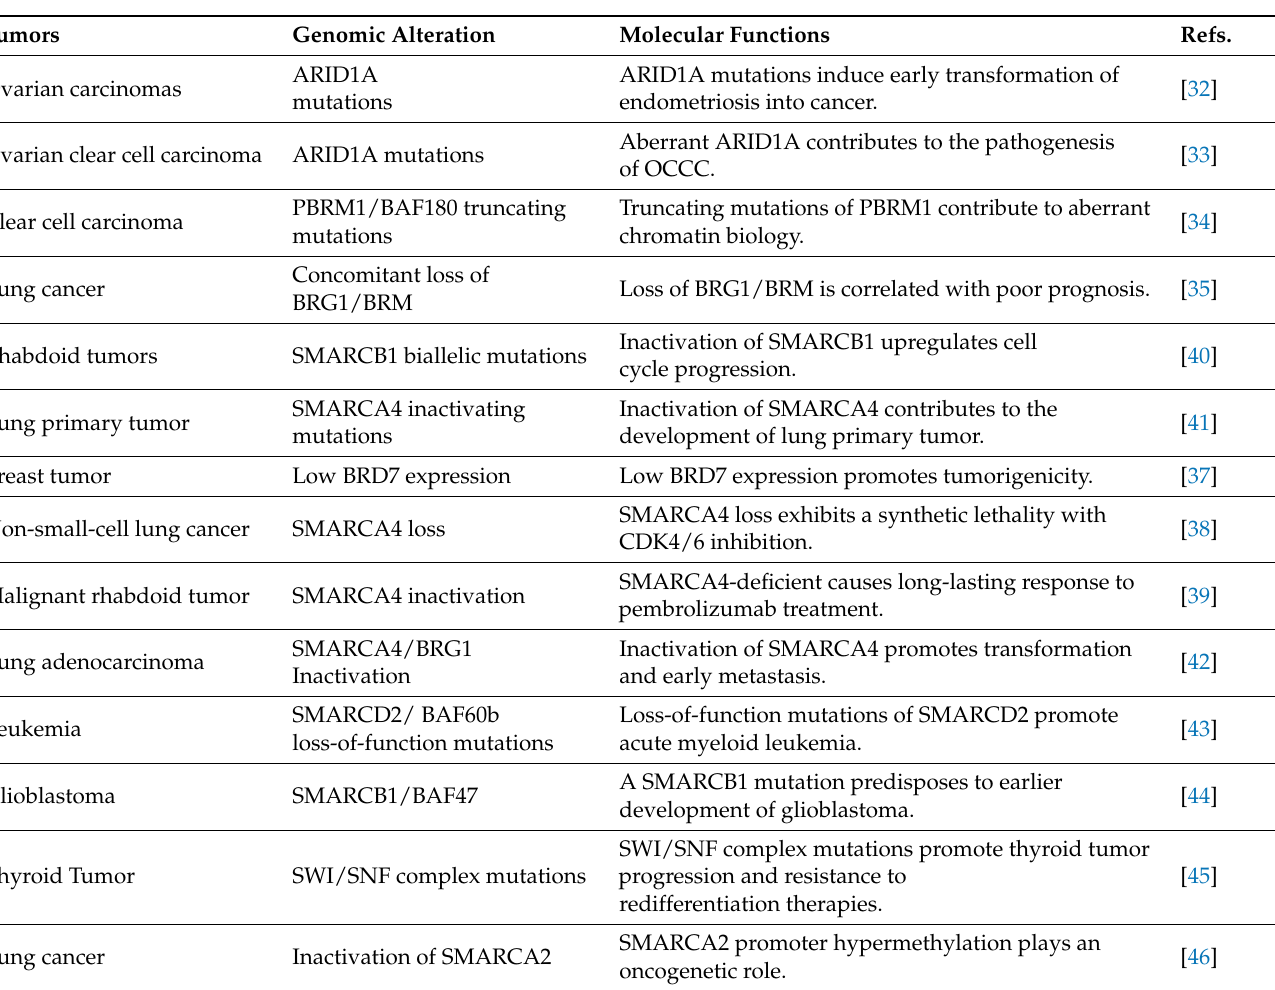
Table 2. Genomic alteration of ATP-dependent chromatin-remodeling factors in